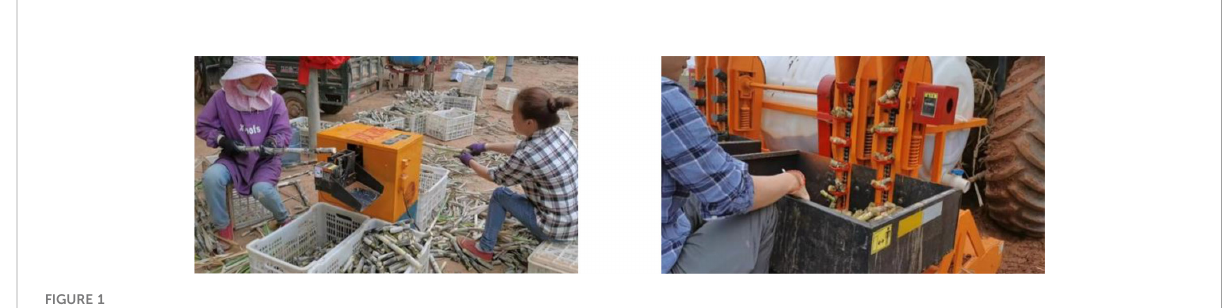
FIGURE 1 Domestic sugarcane cutting